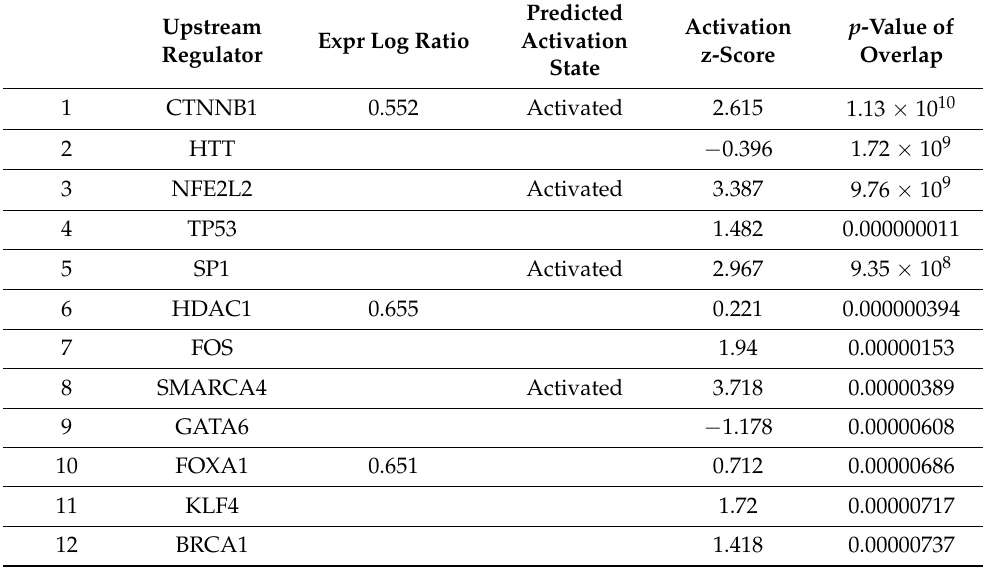
Table 7. The transcription factors identified as Upstream Regulators by Ingenuity Pathway Analysis of the Gene Expression Omnibus dataset on unilaterally nephrectomized mice (GSE 53996). The top 50 of the 230 transcription factors identified by the Ingenuity Pathway